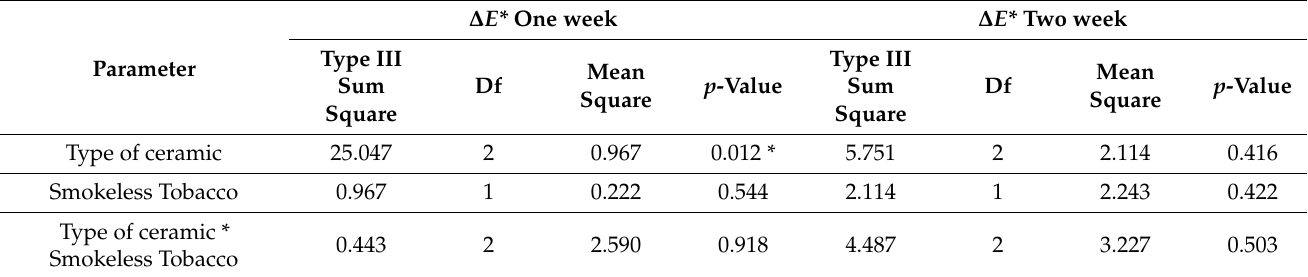
Table 4. Two-way repeated measure ANOVA results of ceramic materials and ST